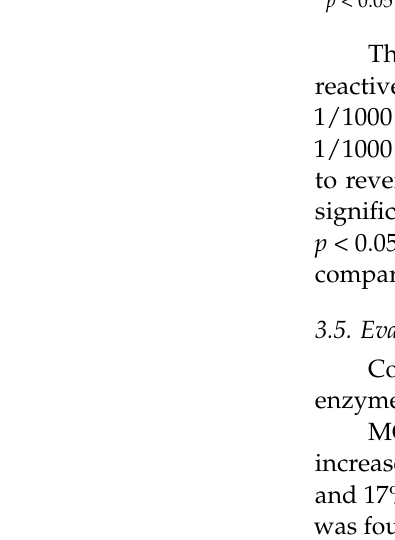
treated with MOLE stock solution dilutions (1/1000 and 1/100 working solution) or vehicle (meth- anol) in culture media for 24 h. Then, hydrogen peroxide (1 mM) was added to samples pre-treated with vehicle or MOLE for a further hour. After treatments, cells were lysed, and then lysates were used for biochemical analysis. Data presented are the means ± S.D. of three experiments performed